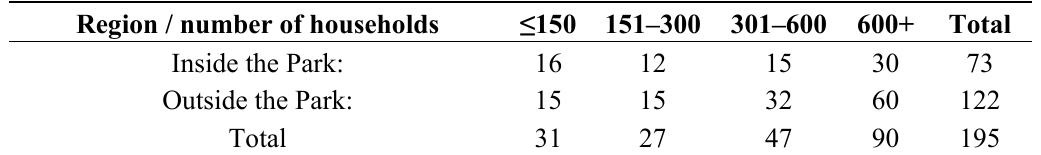
Table 1. Distribution of households in the sample according to size and geographical region.